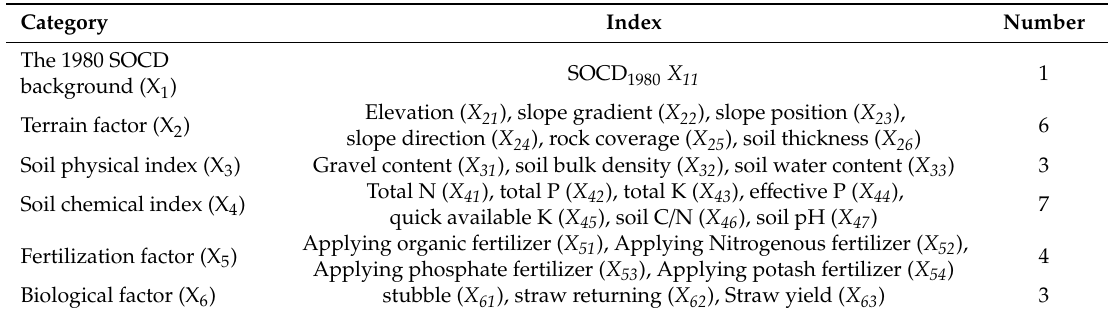
Table 3. Main factors a ff ecting soil organic carbon density (SOCD) change rate of cultivated land in the study